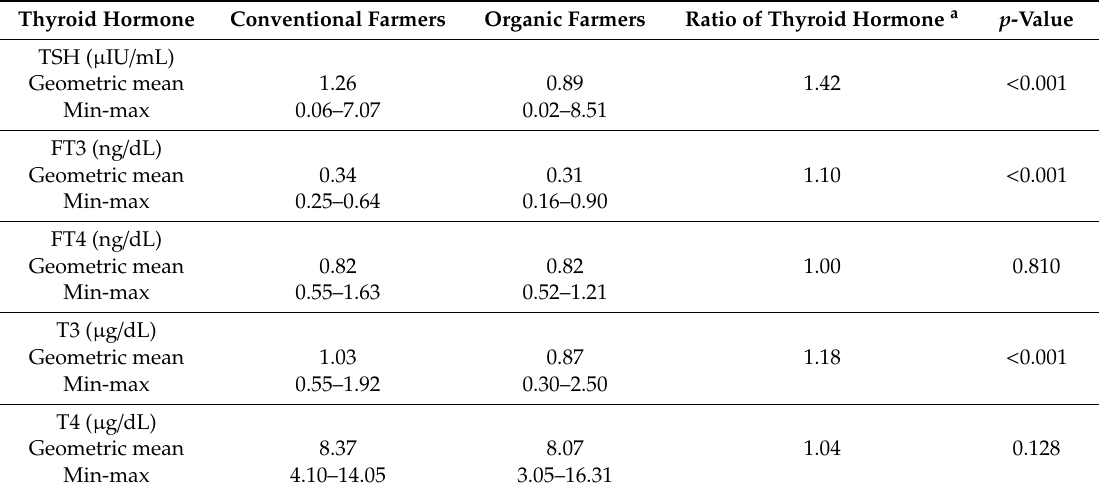
Table 2. Thyroid hormone for conventional farmers ( n = 195) and organic farmers ( n = 222).